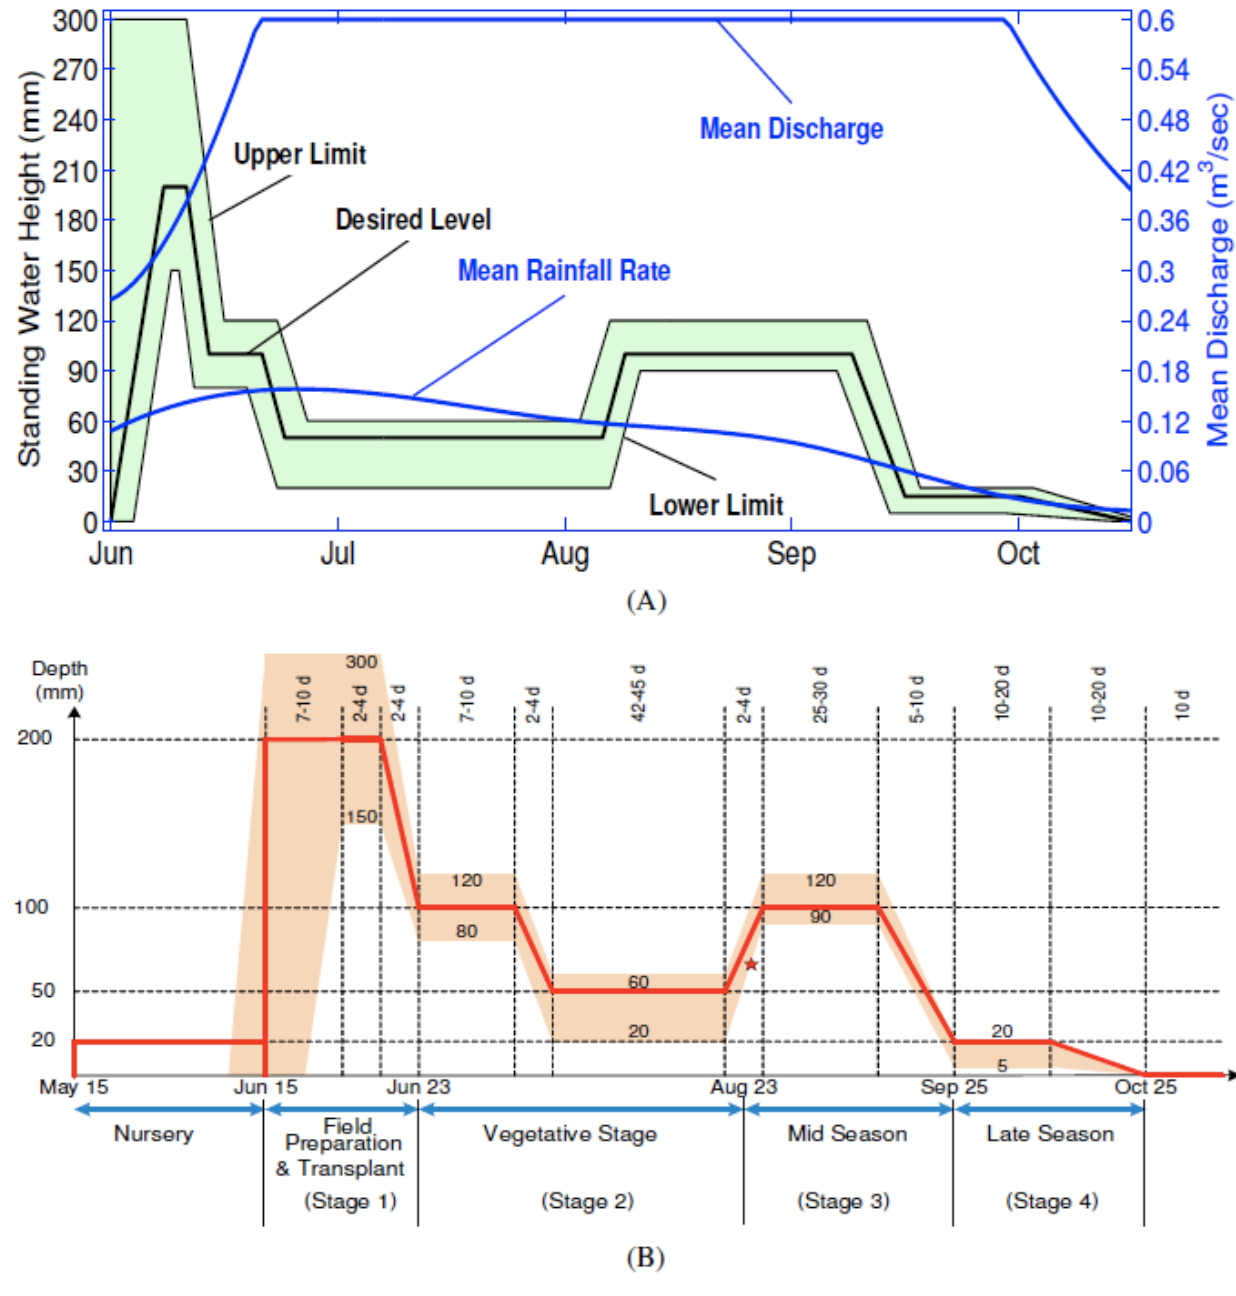
Fig. 4 . (A): Water supply (river regime and rainfall) and (B): desired water level (i.e. demand). Data used to construct figures based on Department of Hydrology and Meterology, Nepal (2002) (rainfall), Nippon Koei Company, Ltd (1986) (riverflow), Brouwer and Heibloem (1986) (water requirements for paddy rice), and Shukla et al. (1993) (paddy planting cycle in